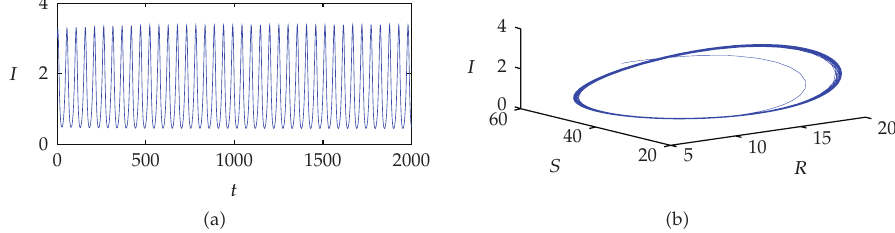
Figure 5: Temporal behavior of the infected and corresponding three-dimensional phase are plotted for the system (cid:2) 1.1 (cid:3) subject to 1 < R c < R 0 < R cc (cid:2) R c (cid:8) 2 . 23, R 0 (cid:8) 2 . 40, R cc (cid:8) 2 . 6 (cid:3) . The parameters are r (cid:8) 0 . 1,